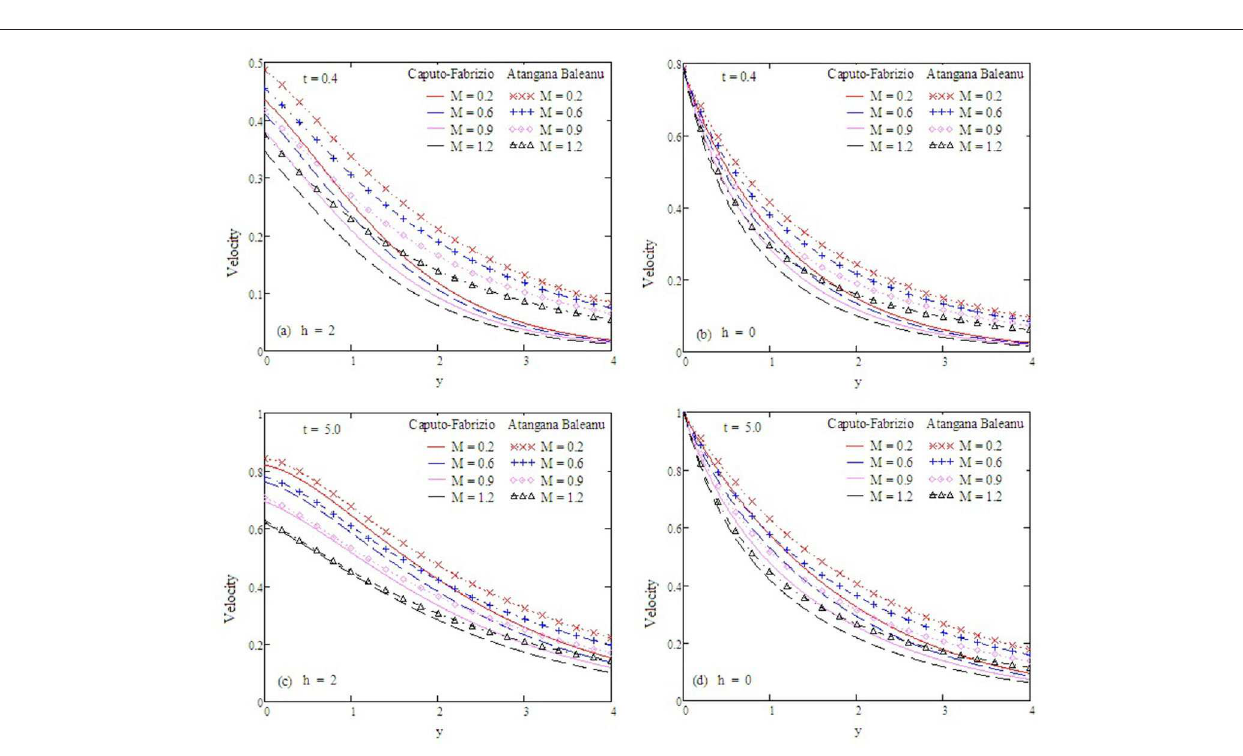
0.2, G r 2, P reff 0.1, α 0.5, k p 1.5, S c 0.5, and M = = = = = =